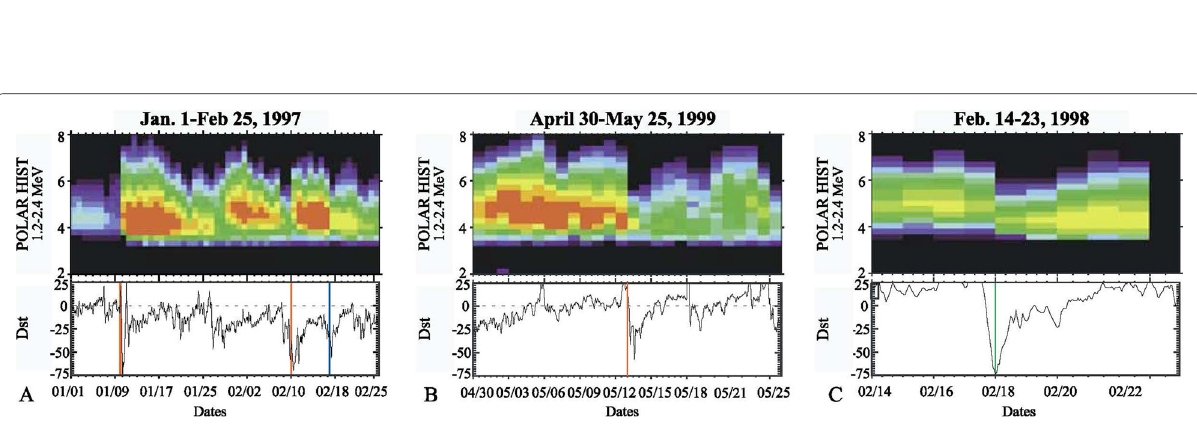
Fig. 10 Radiation belt response during geomagnetic storms of similar strength. The net flux of energetic electrons may increase, decrease, or stay the same between the main and recovery phase illustrating the important dynamic between energization and loss. Figure is reproduced from Reeves et al.